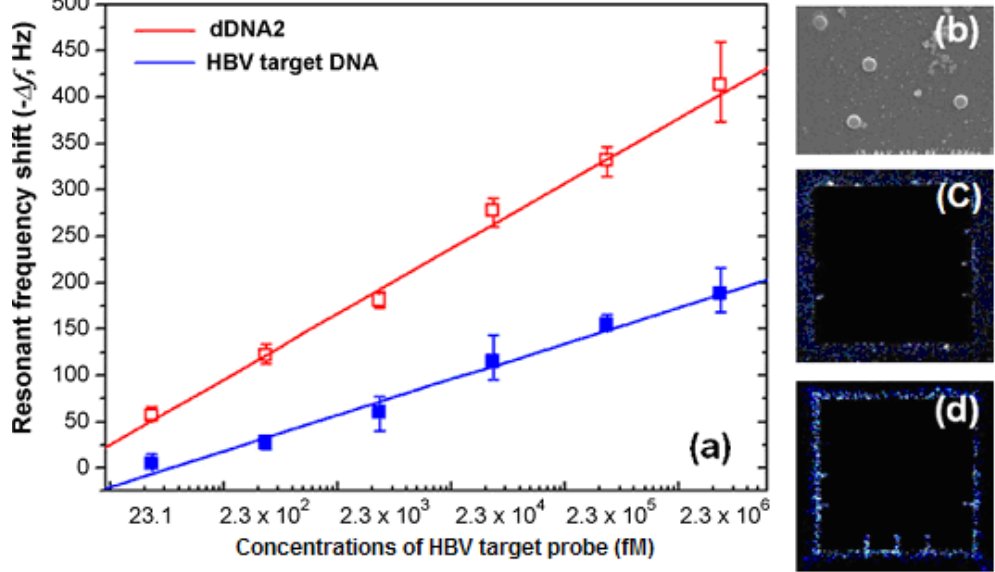
Figure 9. The results of the HBV DNA assay with silicon-nanoparticle (SiNP) enhanced dynamic microcantilevers: ( a ) plots of the resonant frequency shifts acquired from the HBV DNA assay and the SiNP enhanced HBV DNA assay; ( b ) SEM image of the microcantilever surface with the captured SiNPs at 2.3 pM HBV target DNA, and the fluorescent images of the microcantilevers; ( c ) top side and ( d ) bottom side at 2.3 pM (reprinted from [72] with